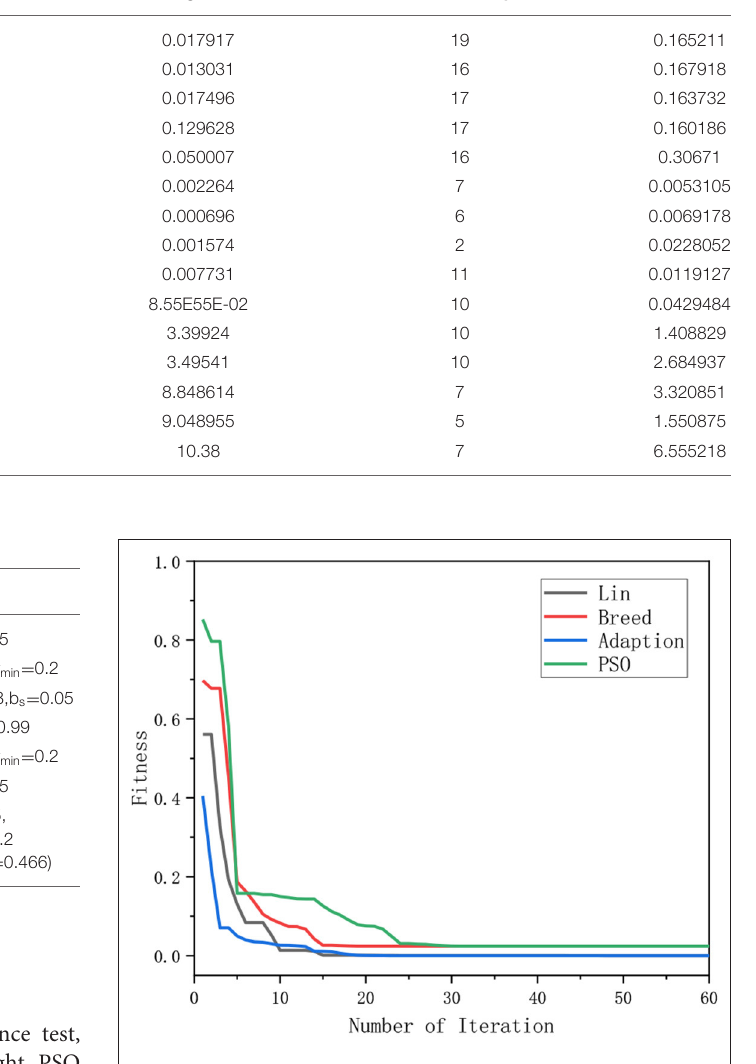
FIGURE 9 | The relation of the fitness value and the number of